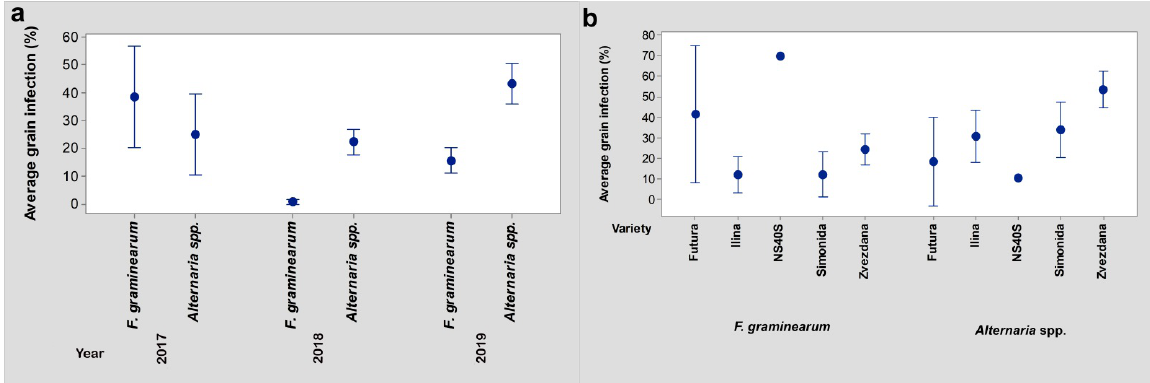
Figure 1. Average grain infection with the F. graminearum clade and Alternaria spp. in a three-year period (2017–2019) from 32 locations in Serbia. ( a ) The effect of the year on grain infection with the F. graminearum clade and Alternaria spp.; ( b ) the effect of the variety on grain infection with the F. graminearum clade and Alternaria spp. In the three-year period, Alternaria spp. were more commonly recovered than members of the FGSC and F. poae in all locations, except in Valjevo and Kula, where the average grain infection with the FGSC ranged between 40% and 50% (Figure 2).